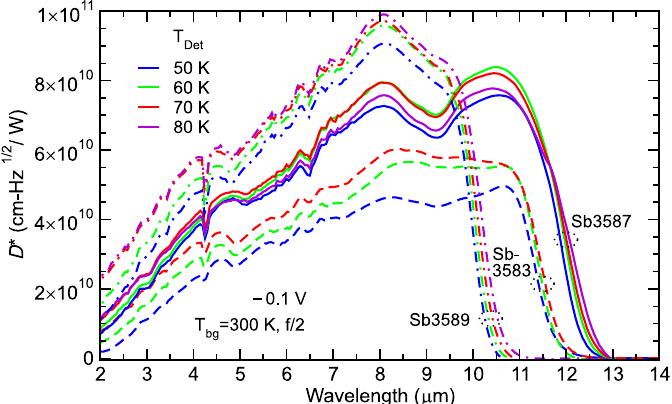
Figure 8. Spectral-specific detectivity ( D *) at several temperature for non-anti-reflection coated detectors fabricated from Sb3583, Sb3587, and Sb3589.